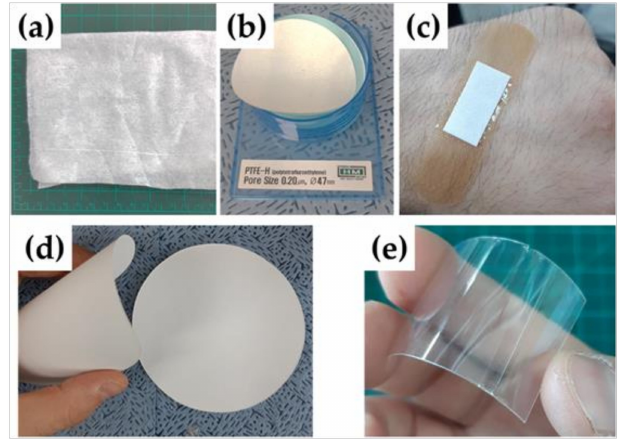
Figure 7. Examples of flexible supports for wearable EFCs that can be easily found in the lab: ( a ) textile fabric; ( b ) a polymeric filter disk; ( c ) a medical skin patch; ( d ) a filter paper disk; ( e ) a flexible transpirant plastic sheet. Many other flexible / stretchable supports were used in the literature.